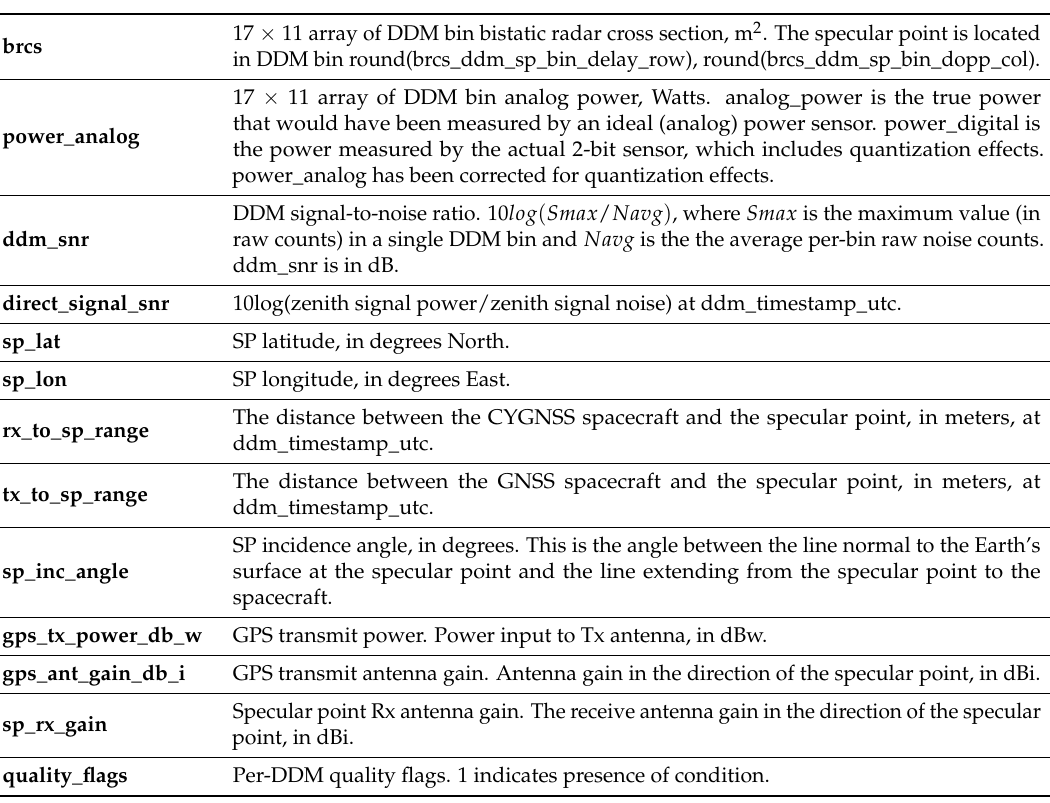
Table A1. CYGNSS Level 1 data that are used in this